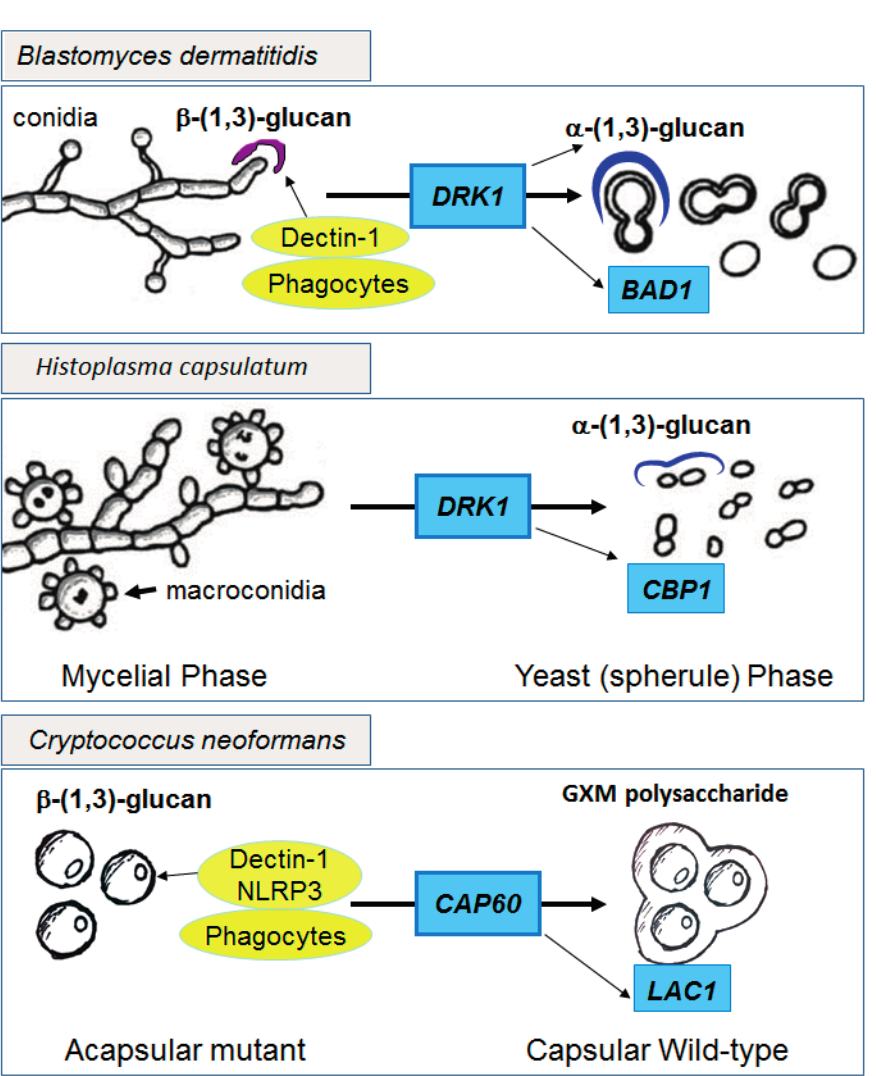
Figure 3. Functional effects of immune shielding by pathogenic fungi. Unshielded fungal forms such as the mycelial phases of B. dermatitidis , H. capsulatum or acapsular mutants of C. neoformans (left panels) provide exposed cell wall β -(1,3)-glucans for innate immune recognition. In contrast, after induction of the yeast forms of dimorphs by DRK1 or with expression of capsular genes such as CAP60 in C. neoformans , shielded yeast forms display reduced immune recognition and increased virulence (right panels). Additional virulence genes such as BAD1 , CBP1 and LAC1 contribute to pathogenicity in the three fungi,